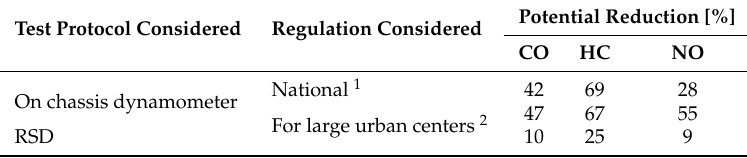
Table 4. Potential percentage of reduction of tailpipe HC, CO and NO emissions from vehicles in MMA as a result of the implementation of an I/M program.